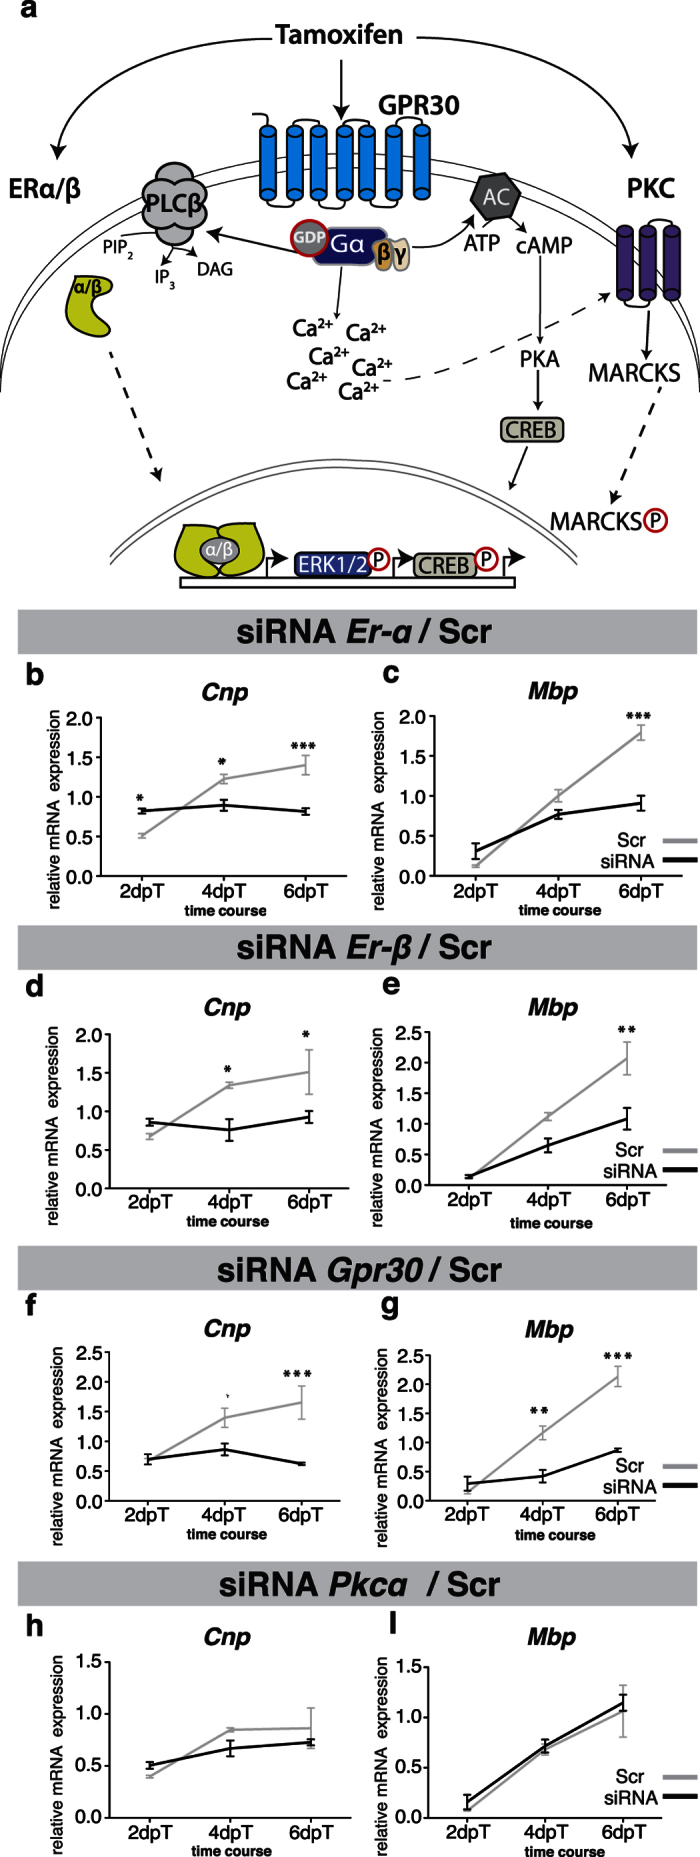
ERα, ERβ, and GPR30 are important regulators of OPC differentiation.(a) Model of tamoxifen signalling in OPCs: (1) tamoxifen binds nuclear ERα/β receptors, which respond by modulating transcriptional events; (2) tamoxifen can also activate membrane bound GPR30 receptors, inducing an increase in intracellular Ca2 + levels. This in turn activates adenylate cyclase (AC), resulting in activation of protein kinase A (PKA) and CREB1. Furthermore, (3) tamoxifen is also able to inhibit PKCα, which is known to modulate cytoskeletal proteins, including MARCKS, and inhibit OPC differentiation. (b–i) Line graphs demonstrating impaired OPC differentiation (decreased expression of Cnp and Mbp mRNA relative to glyceraldehyde-3-phosphate dehydrogenase) when OPCs were transfected with siRNA for Er-α, Er-β or Gpr30 as compared with non-targeting scrambled siRNA (Scr, gray line). Gene silencing of Prkcα did not negatively affect the differentiation of OPCs on control substrates (n = 3). Oneway ANOVA with Bonferroni’s post-hoc tests: *p < 0.05, **p < 0.01, ***p < 0.0001. dpT, days post siRNA transfection. Error bars: SEM.